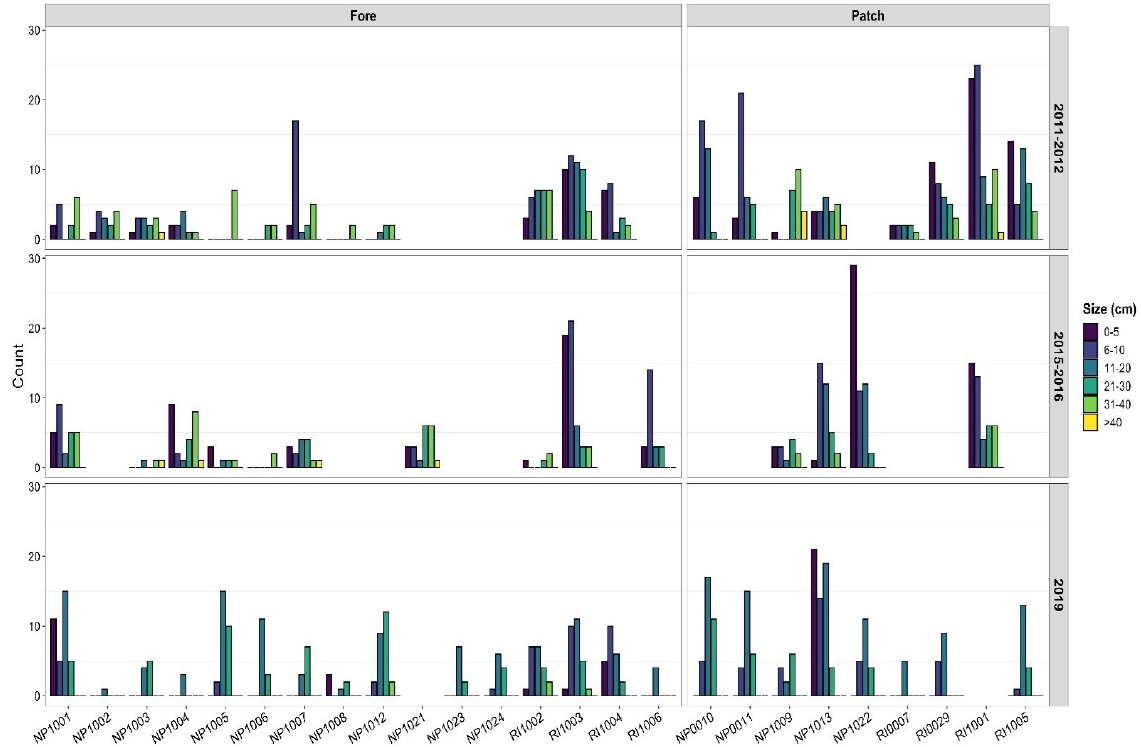
Figure 7. Size frequency distribution showing the total number of Stoplight Parrotfish ( Sparisoma viride ) in different size classes across each survey period for New Providence. Sites with dashed lines indicate zeros and those with completely blank spaces represent sites where no data were collected during that survey period. Size frequency distributions for Sp. viride showed similarities in the number of indi- viduals from different size classes between 2011–2012 and 2015–2016 (Figures 7 and 9). During the last survey period, there was a notable increase in the number of fish in both the 11–20 and 21–30 cm size categories. Approximately 27% of all Sp. viride observed were between 11 and 20 cm TL and less than 1% were >40 cm in size (Figure 9). Differences in the size structure of Sp. viride were significant across reef zones (Pearson’s chi-squared test = 22.155, df = 4, p -value = 0.002) with the positive associations of larger individuals occurring in forereef versus patch reef areas (Figures 9).